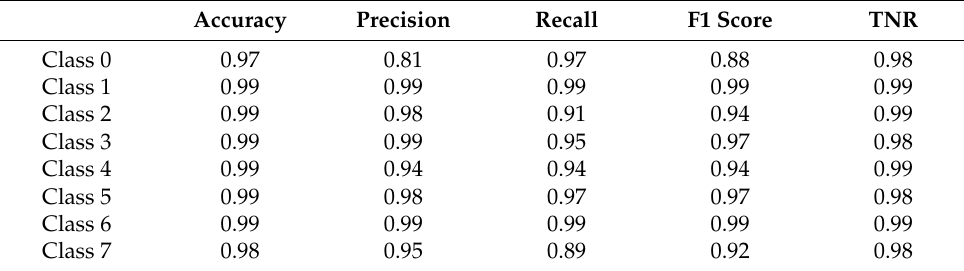
Figure 8. Confusion matrix for SWaT dataset. Table 3. Summary of